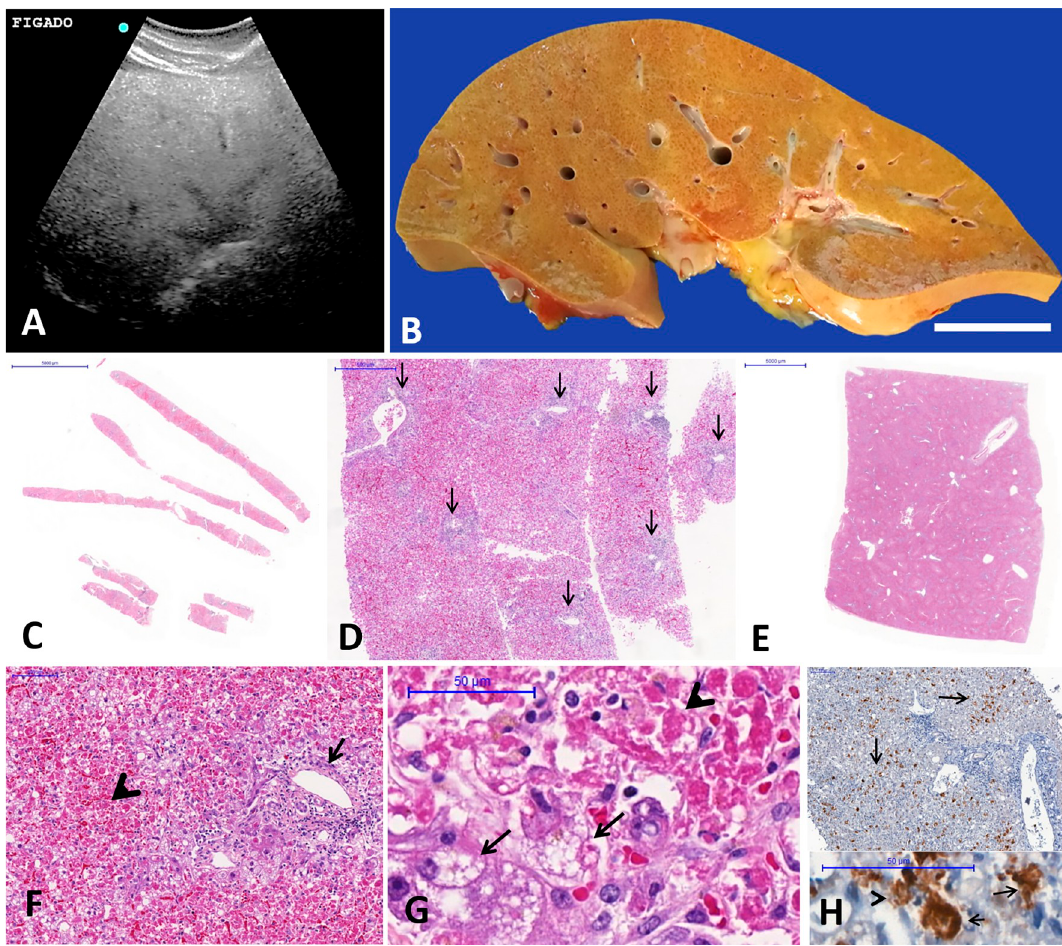
Fig 2. Post-mortem liver examination from fulminant yellow fever cases performed by ultrasound-guided minimally invasive autopsy (MIA-US) and conventional autopsy (CA). (A) Post-mortem abdominal ultrasound demonstrating hepatic steatosis; (B) gross exam of the liver with YF hepatitis, showing yellowish color due to diffuse steatosis; (C–D) adequate post-mortem liver samples, collected through MIA-US (C), with sufficient lobular areas and number of portal tracts (arrows in D); (E) micrograph of an H&E slide at low magnification demonstrating the usual sampling of the hepatic parenchyma collected at CA; (F) micrograph of YF hepatitis–portal tract with mild lympho-mononuclear inflammatory infiltrate (arrow) and severely damaged mid-zonal hepatocytes (arrowhead); (G) micrograph showing mid-zonal hepatocytes with steatosis (arrows) and acidophilic degeneration–the so-called Councilman-Rocha-Lima bodies (arrowhead), Kupffer cell hyperplasia, and minimal inflammatory reaction; (H) micrographs showing detection of YFV antigen in the liver parenchyma by immunohistochemistry, mainly in the mid-zonal area in a sample collected by MIA-US (arrows). At the bottom, Councilman-Rocha-Lima bodies (arrows) and Kupffer cells (arrowhead) labeled with anti-YFV (IHC). C–G: H&E staining, H: immunohistochemistry for